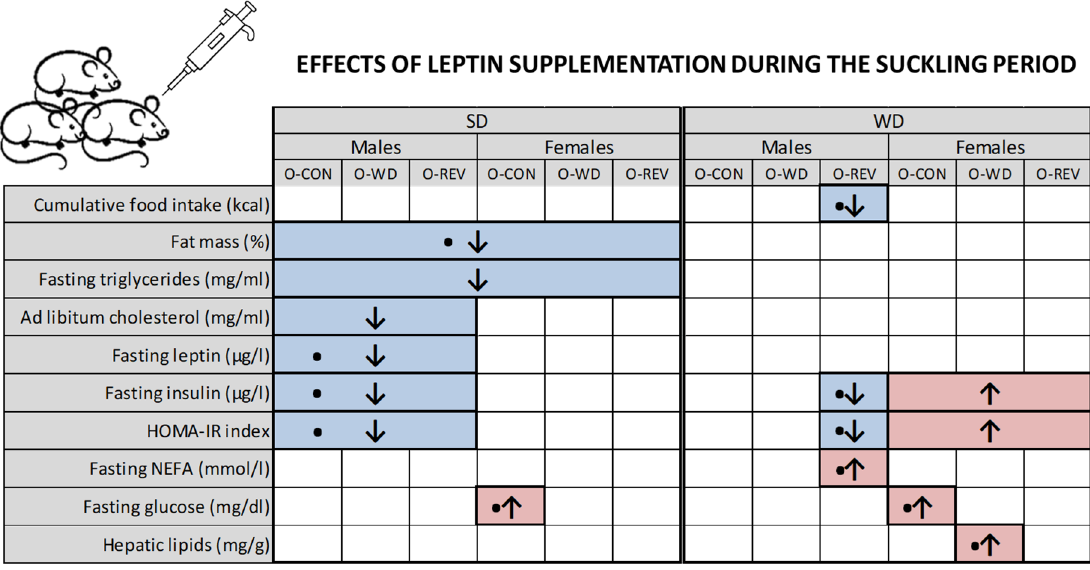
Figure 8. Summary of the effects of leptin supplementation during suckling on cumulative food intake (from one to four months of age), fat mass and hepatic lipid content (four months), and circulating parameters in adult O-CON, O-WD and O-REV male and female rats weaned onto SD or WD. Circulating parameter were determined at four months (under feeding conditions), or at three and a half months (under fasting conditions). Abbreviations: offspring of CON-dams (O-CON), offspring of WD-dams (O-WD), offspring of REV-dams (O-REV), standard diet (SD), western diet (WD). Symbols: ↑ and ↓ indicate increases or decreases, respectively, by Mann-Whitney U test, two-way ANOVA, or three-way ANOVA with respect to their vehicle-treated equals; ● , signi fi cant difference in the indicated group with respect to its vehicle-treated equal by Mann-Whitney U test.